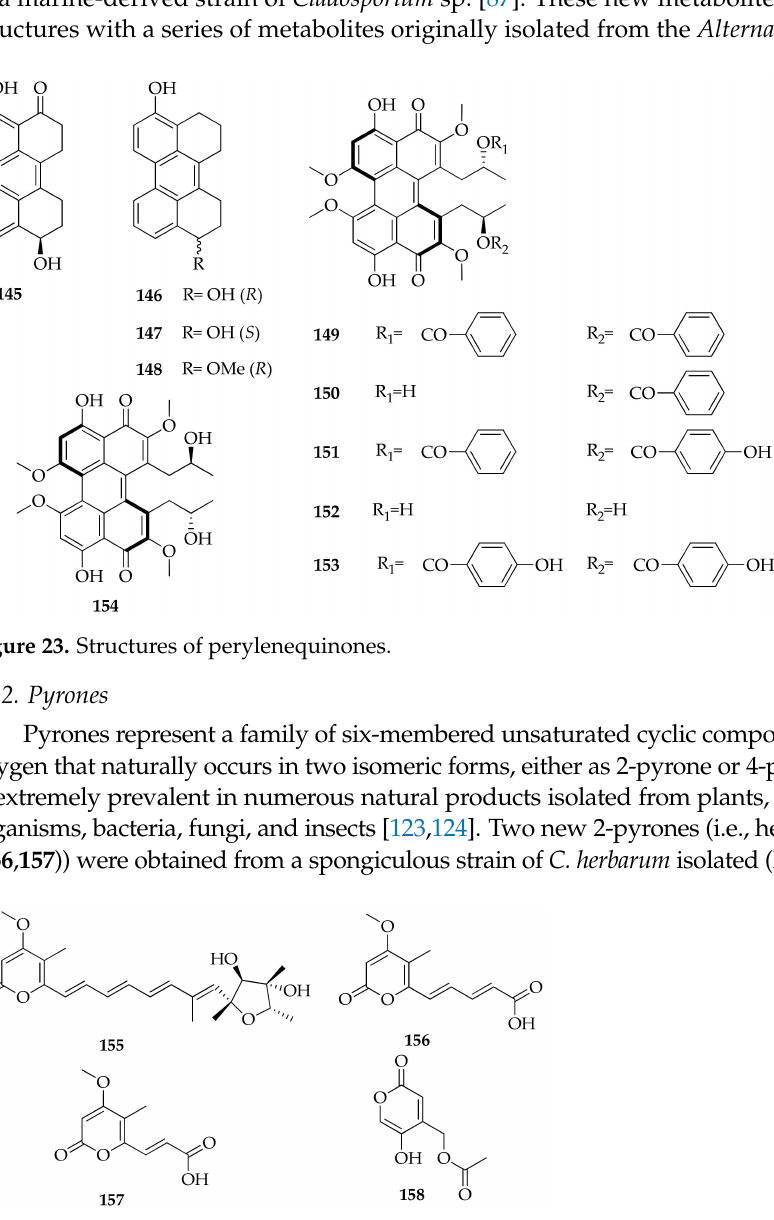
Figure 24. Structures of